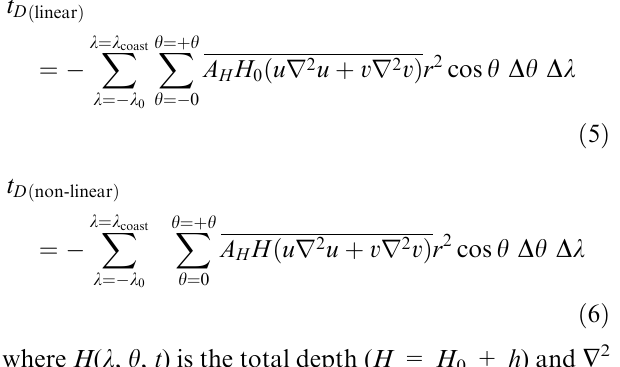
( C0-L ). Center-dashed line : non linear experiment with Pacific coastline ( PAC-NL ). Dotted line : non linear experiment with meridional coastline ( C0-NL ). Wave period: 60